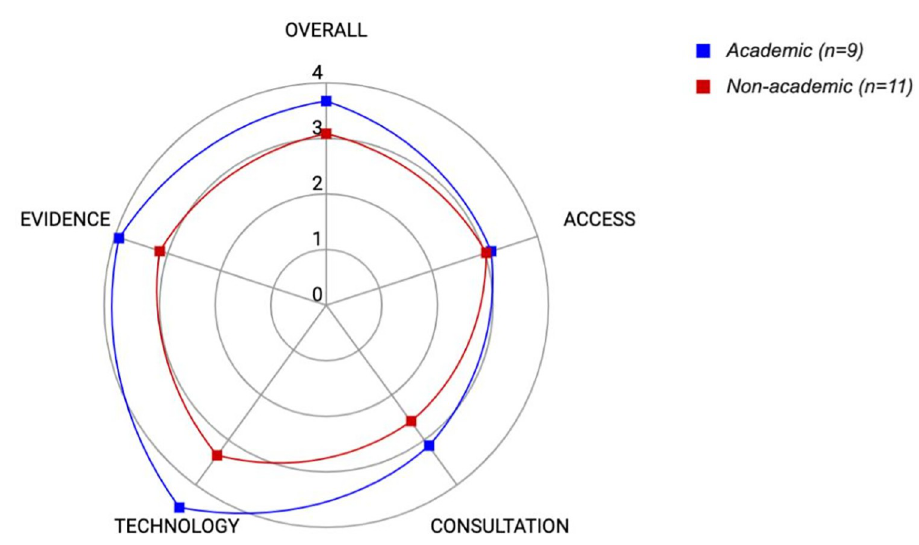
Fig 4. Comparison of averaged overall and domain maturity scores for academic vs. non-academic